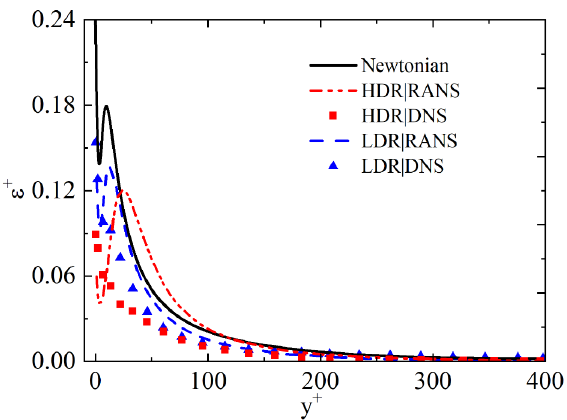
Figure 4. Comparison of ε + between the current work and the DNS. ε + is the dimensionless turbulent dissipation rate.